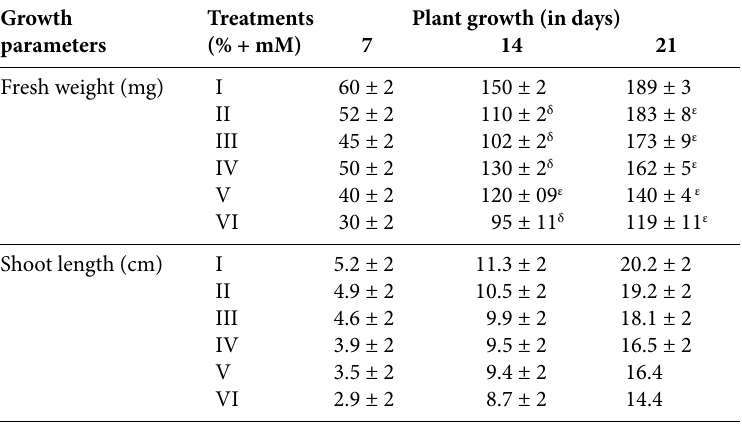
Table 2 . Growth parameters: Fresh weight and % Germination of wheat for different treatments Growth Treatments Plant growth (in days)